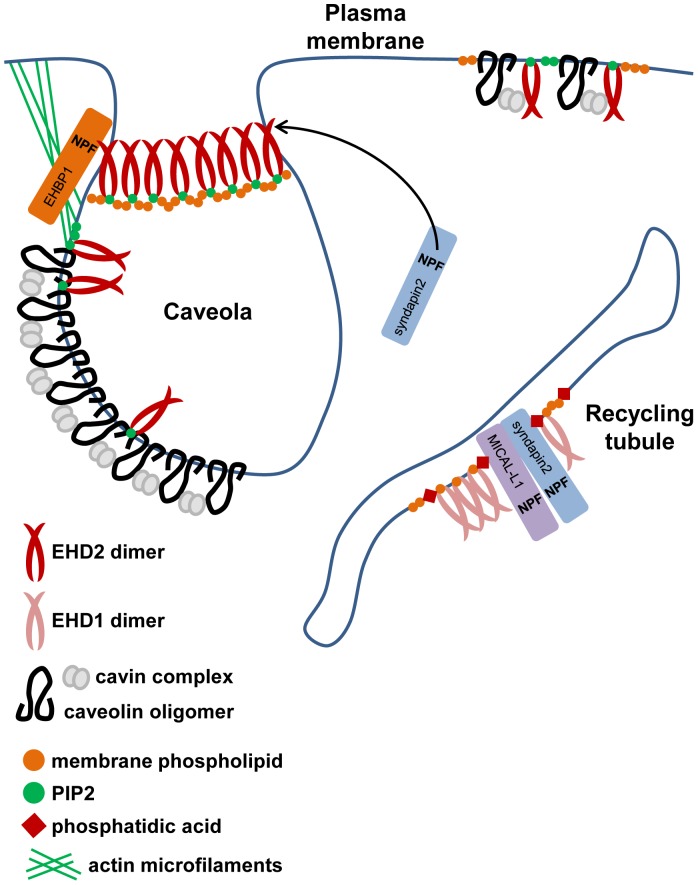
Model of EHD2 and EHD1 membrane localization.EHD2 localizes to the plasma membrane, and is predicted to form large oligomers at the neck of caveolae. PIP2, which is enriched in plasma membrane domains, including caveolae, has a crucial role in maintaining EHD2 at the cell surface. In the absence of caveolar invaginations, EHD2 maintains its plasma membrane association, likely through binding to PIP2 and, potentially, protein interactions mediated outside of the EH2 domain. EHD2 binds to the F-BAR domain-containing protein syndapin2, which facilitates membrane curvature, and also to EHBP1, which connects to the actin cytoskeleton. In contrast, localization of EHD1 to tubular recycling endosomes depends on binding of the EH1 domain to MICAL-L1 and sydnapin2, which require phosphatidic acid for their recruitment to the tubular recycling endosomes.